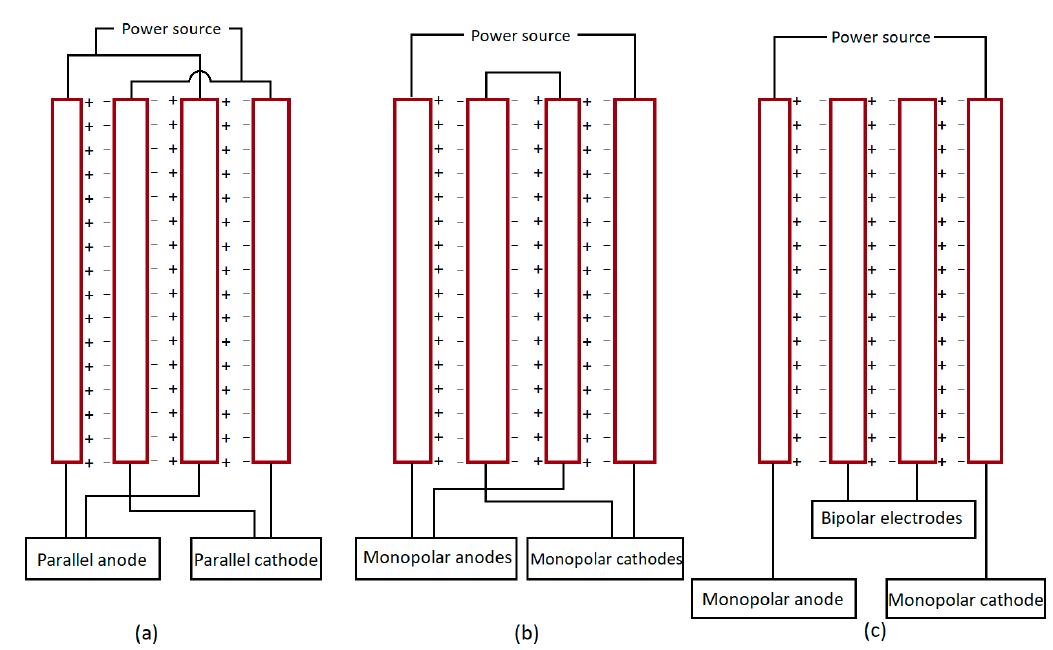
Figure 4. Different electrodes arrangements in an electrochemical cell: ( a ) MP-P; ( b ) MP-S; ( c ) BP-S.